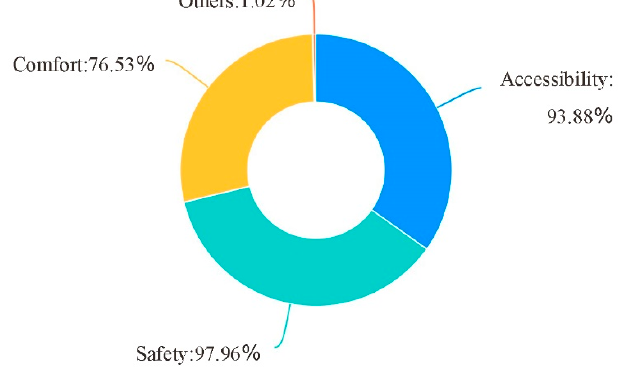
Table 4. Analysis of characteristics of children’s school travel activities and walking environment demand. Behavior Classification Specific Behavior Walking Environment Needs Walking Through Continuous, accessible and safe sidewalk space Walking Crossing the Street Safe crossing environment and facilities guarantee Chasing Each Other Safe and relatively wide walking space Staying Playing Playing and Running Playing Source of information: according to the field investigation.